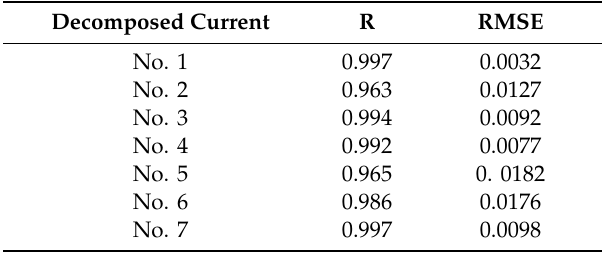
Table 2. Similarity coe ffi cient and RMSE between the decomposed signal and the actual signal in second home.